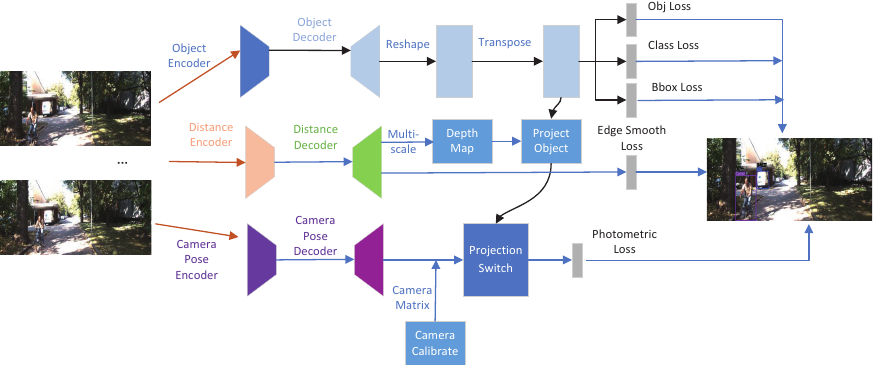
Figure 4. Overview of our proposed framework for the joint prediction of distance and object detection. The first row describes the prediction of the object detection, the second row describes the steps for the depth estimation, and the third row describes camera pose parameters.